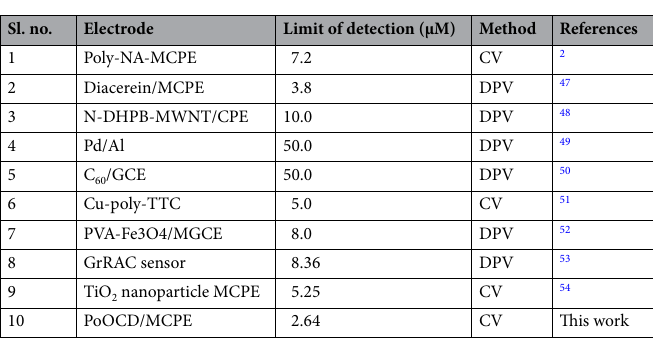
Table 2. Comparisons of the LOD of PoOCD/MCPE with other modified electrode reported.